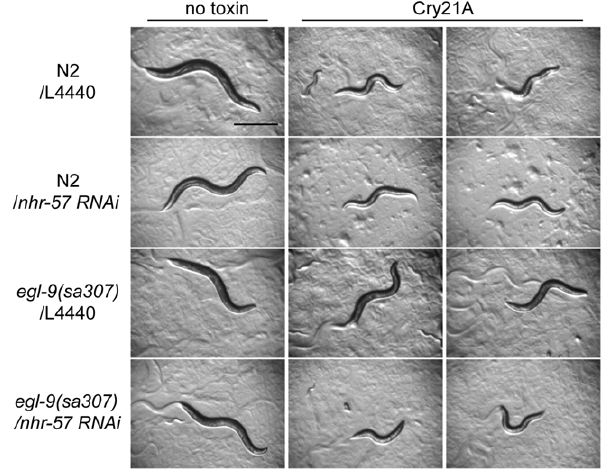
Figure 6. nhr-57 , a HIF-1-target, is required for loss of egl-9 - mediated resistance to PFT. Wild-type N2 and egl-9(sa307) mutant animals were treated to RNAi using either empty vector (L4440) or dsRNA for nhr-57 and exposed to E. coli -expressed Cry21A PFT for 48 hours. Shown are representative animals for each condition. All animals are healthy in the absence of Cry21A. On Cry21A, whereas egl- 9(sa307) animals are resistant (third row), nhr-57(RNAi) egl-9(sa307) animals are